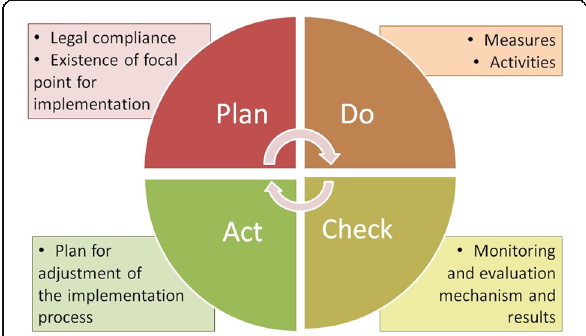
Fig. 1 Analysis framework based on Deming ‘ PDCA ’